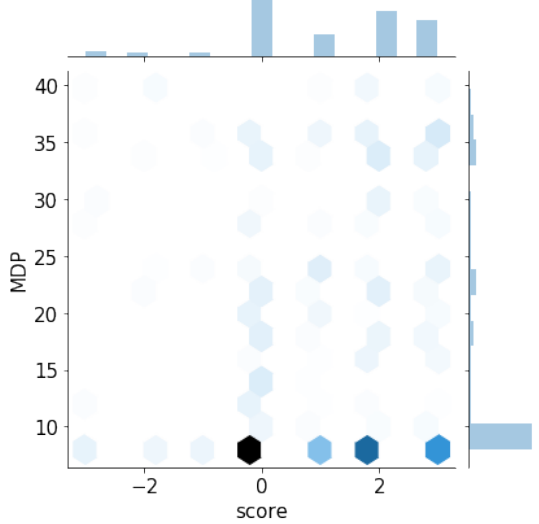
Figure 8. Joint plot between individual scores on all motivational design techniques and the score on the mobile device proficiency